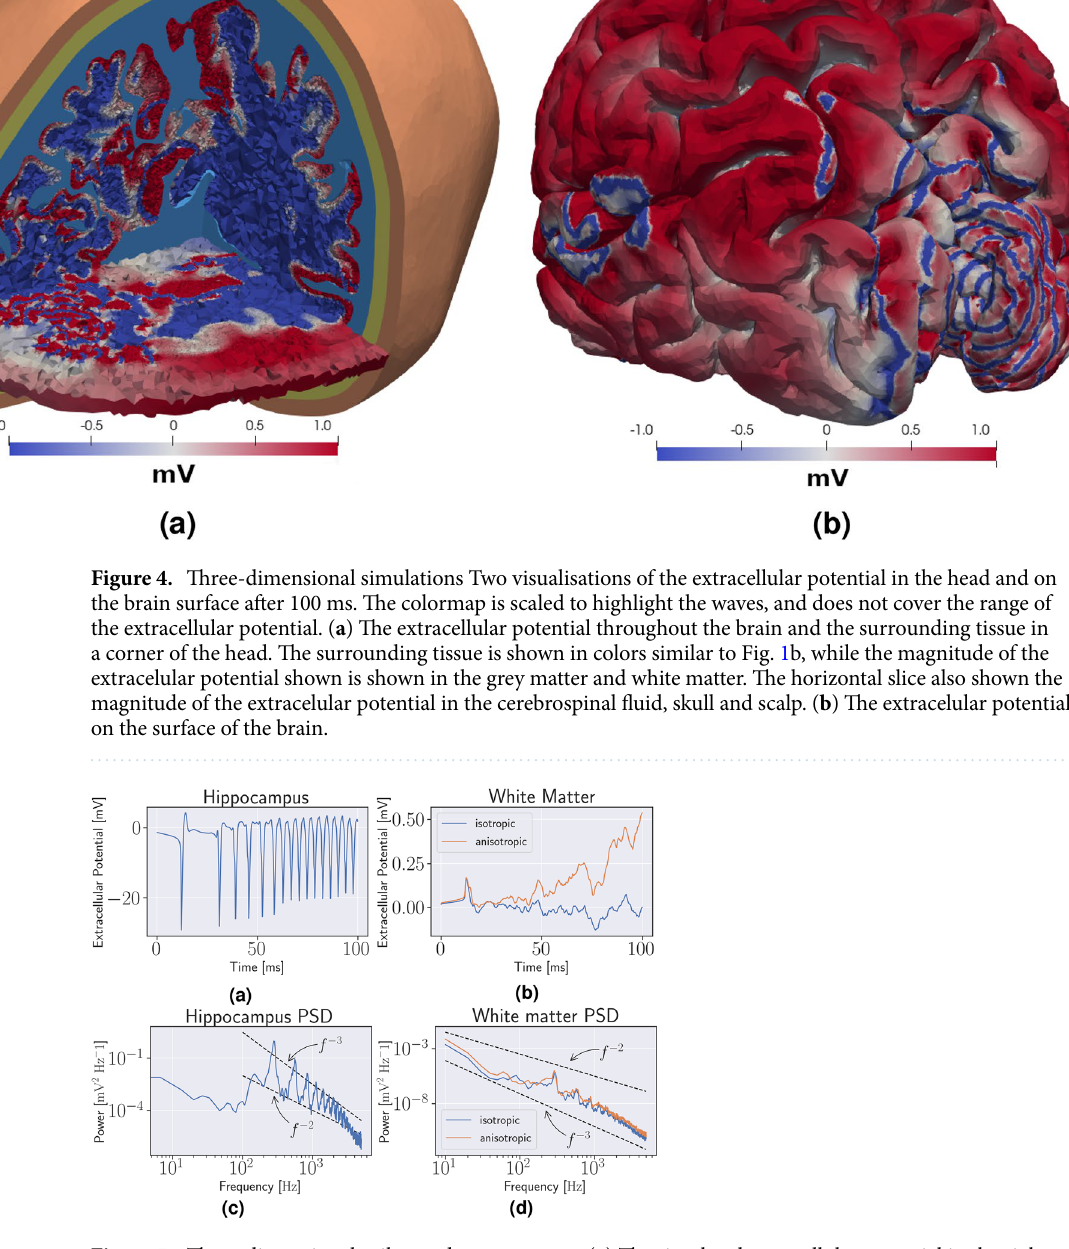
Figure 5. Three-dimensional spikes and power spectra ( a ) The simulated extracellular potential in the right hippocampus in Model E. ( b ) The extracellular potential in the white matter in the left hemisphere from Model E and Model F. ( c ) The power spectrum of the potential in ( a ). ( c ) The power spectrum of the potential in ( b